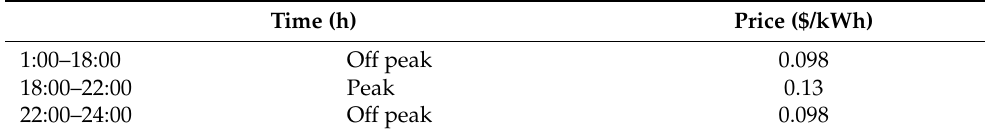
Table 2. Electricity prices.